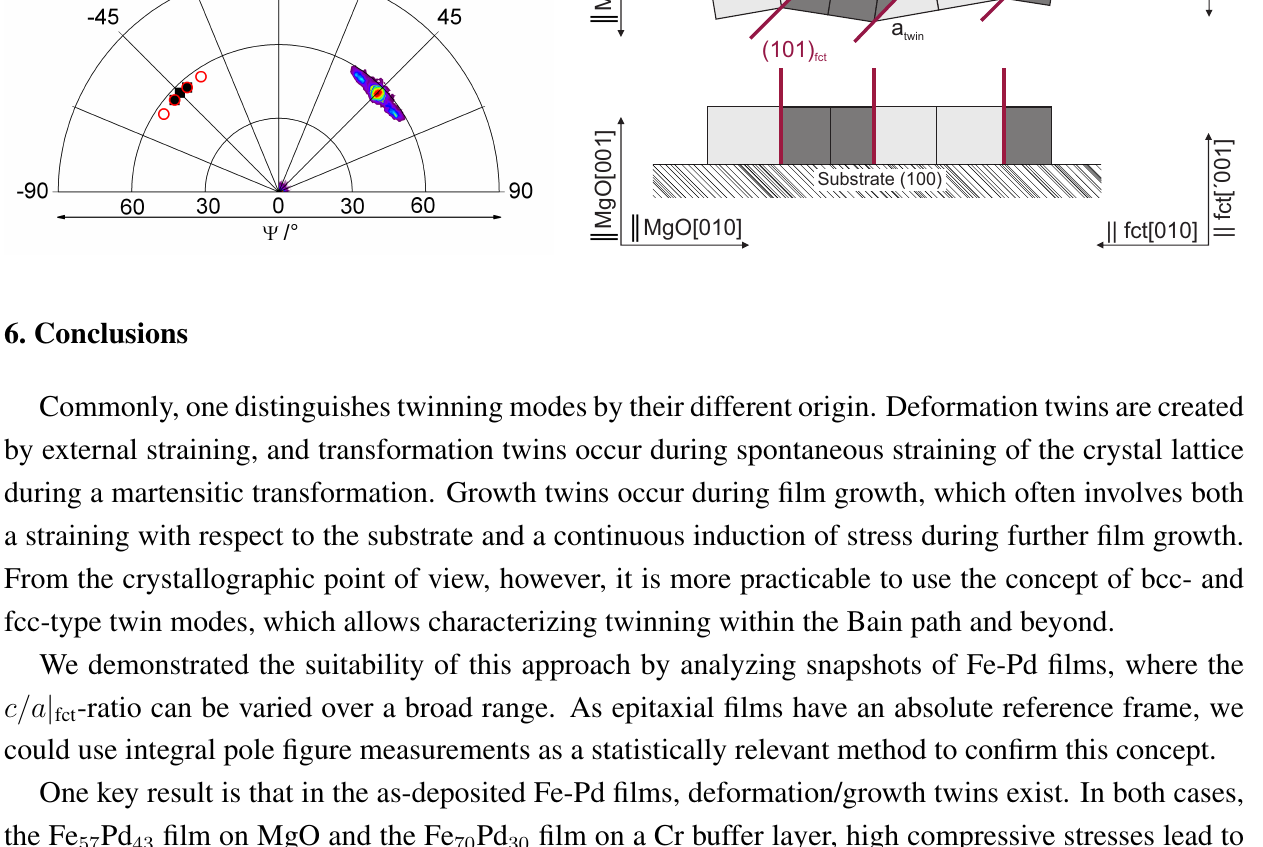
pole figure of a Fe Pd film on 70 30 fct nanotwins fct